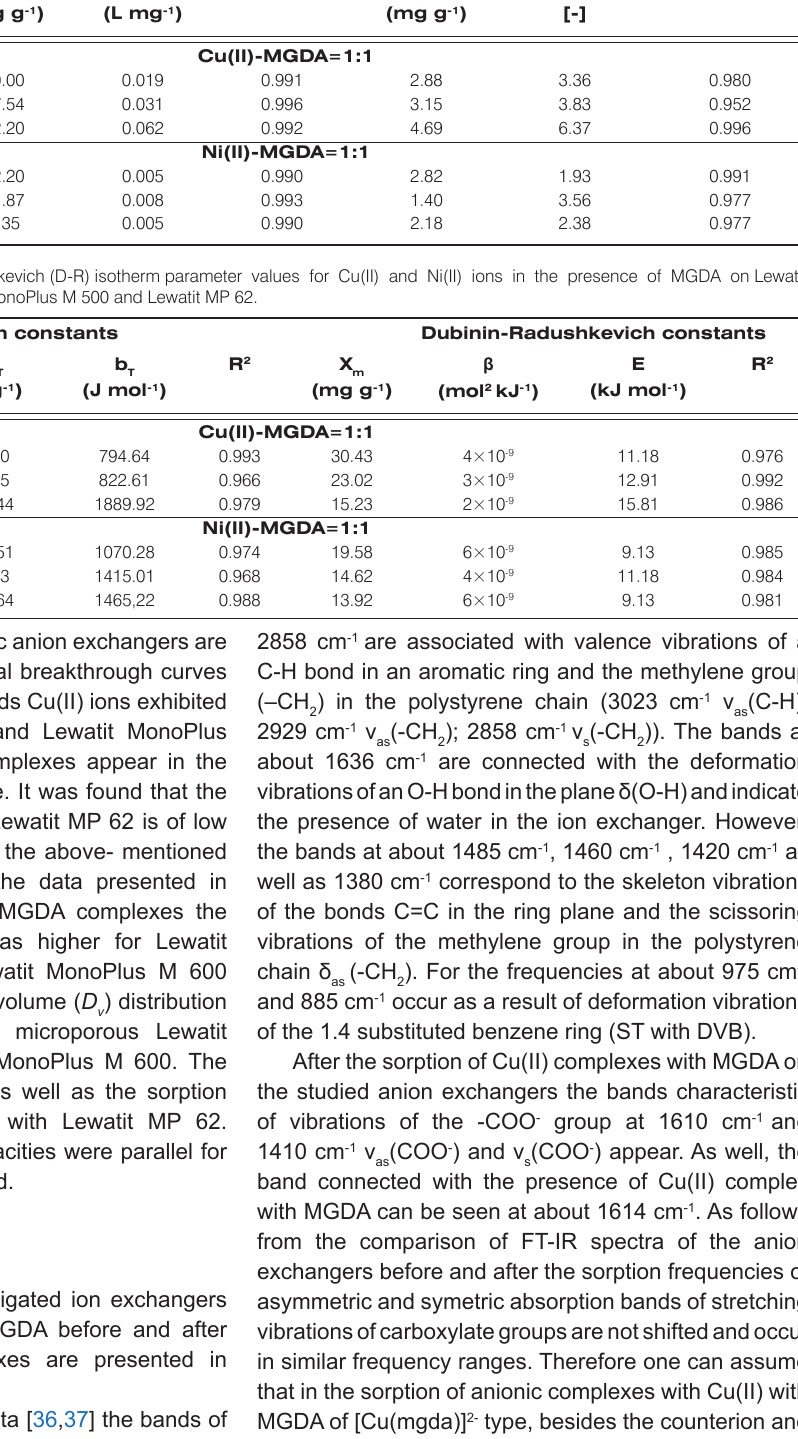
Table 5. Langmuir and Freundlich isotherm parameter values for Cu(II) and Ni(II) ions in the presence of MGDA on Lewatit MonoPlus M 600, Lewatit MonoPlus M 500 and Lewatit MP 62. Langmuir constants Ion